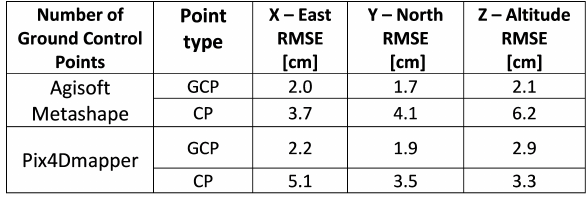
Figure 13: Statistics on GCPs and CPs with Agisoft Metshape and